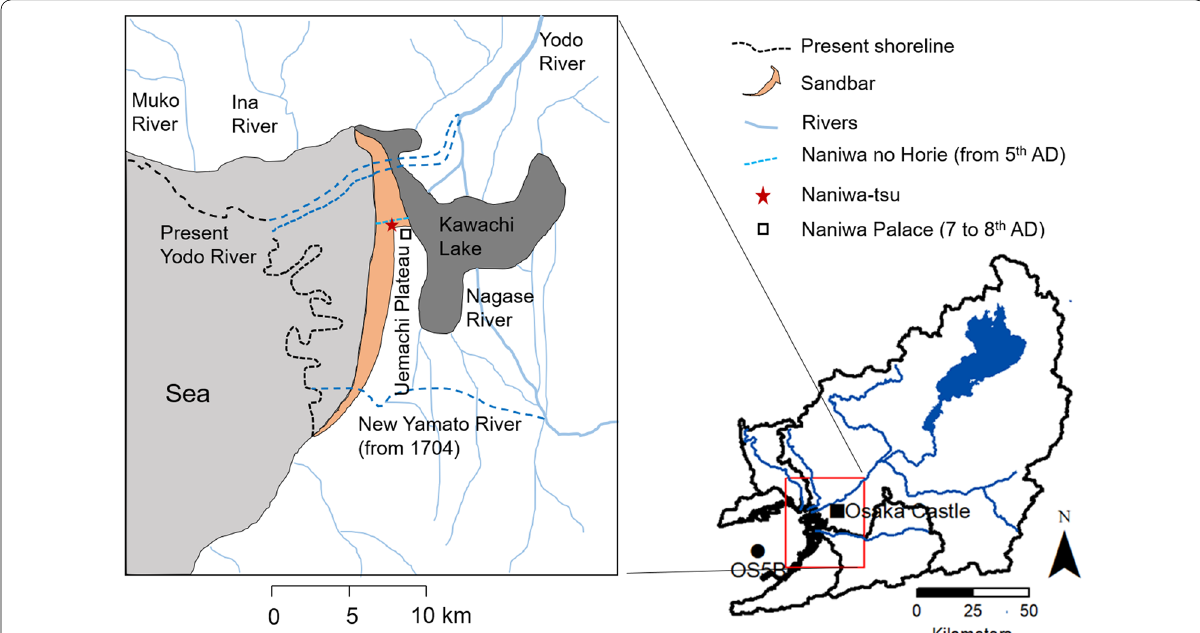
Fig. 2 Kawachi Lake during the third and fourth centuries AD with location of the inset in the Osaka Bay catchment. The locations of the Naniwa no Horie canal, the port Naniwa-tsu (constructed in the fifth century AD), of Naniwa Palace, and of the present Yodo River and Yamato River are also shown. Modified after Kajiyama and Itihara (1986), Kajiyama and Itihara (1972), and Kusaka